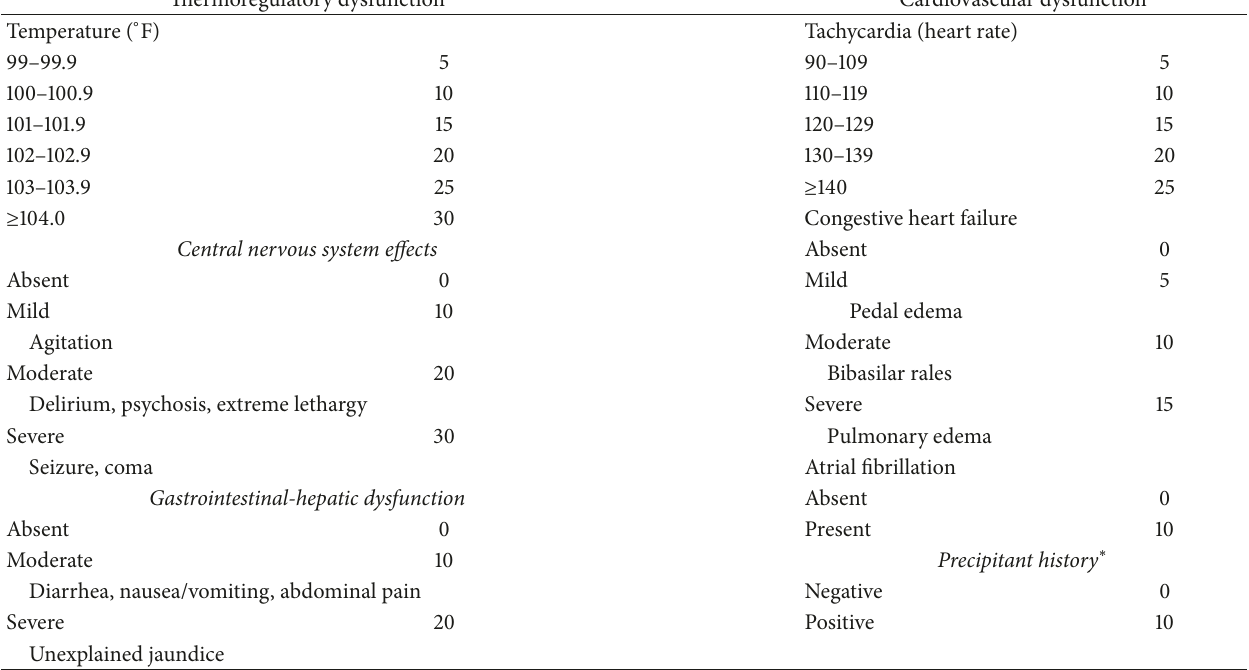
Table 1: Diagnostic criteria for thyroid storm established by Burch and Wartofsky. A score below 25 is unlikely to represent thyroid storm, a score between 25 and 44 is suggestive of impending thyroid storm, and a score greater than or equal to 45 is highly suggestive of thyroid